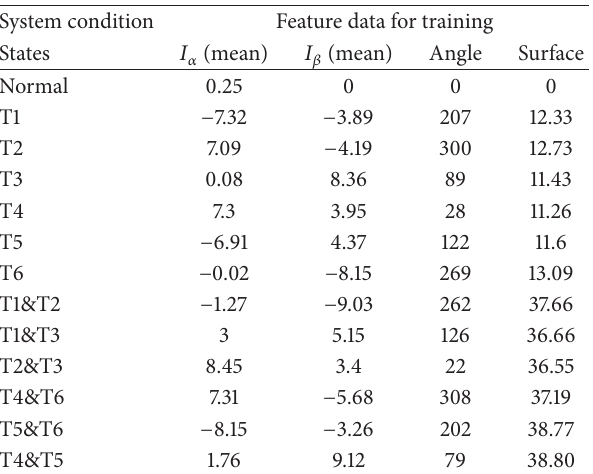
Table 1: Feature data for training neural network.